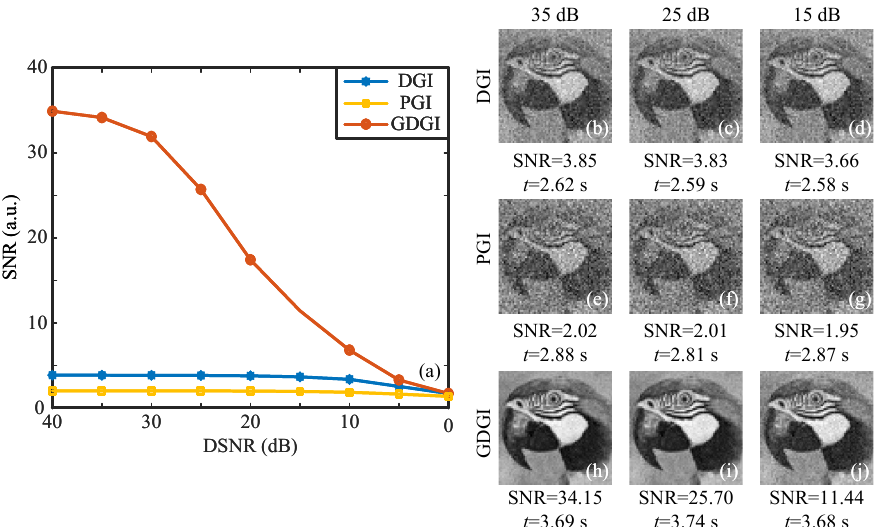
Figure 6. Simulation results for the grayscale image labelled “02” using the DGI, PGI and GDGI algorithms under different detection signal-to-noise ratios (DSNRs). ( a ) gives the changes in the SNRs of the DGI, PGI and GDGI with the DSNRs, ( b – d ), ( e – g ) and ( h – j ) are the images retrieved by the DGI, PGI and GDGI, with the DSNR being 35 dB, 25 dB, 15 dB.